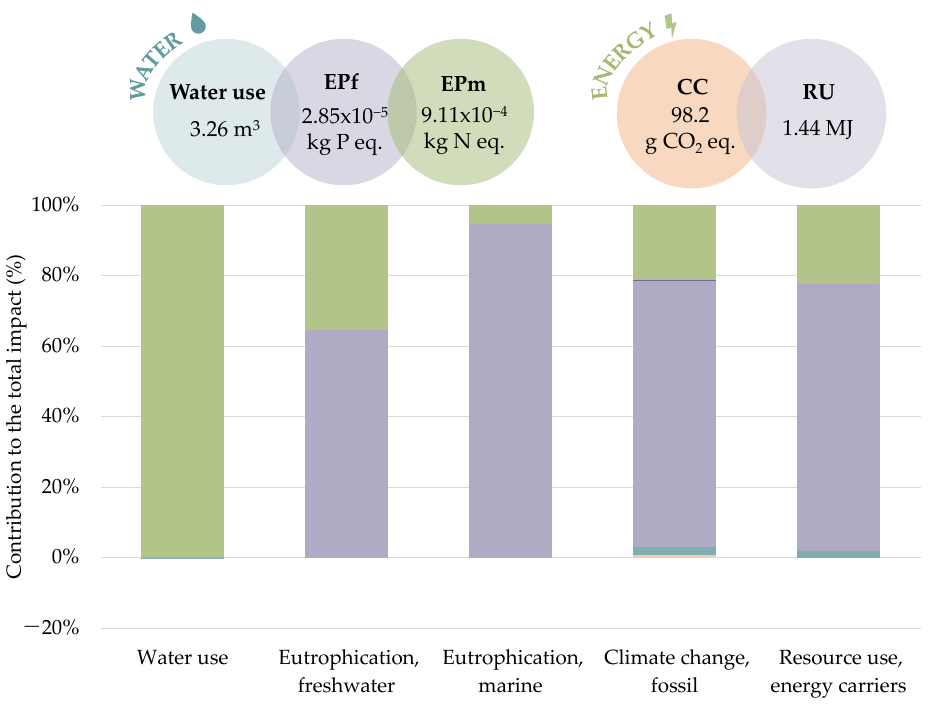
Figure 4. Water- and energy-related indicators of potato chips production. At the top, the total value of each indicator is provided per FU; at the bottom, the contribution of each life cycle stage to the environmental impact categories is presented.